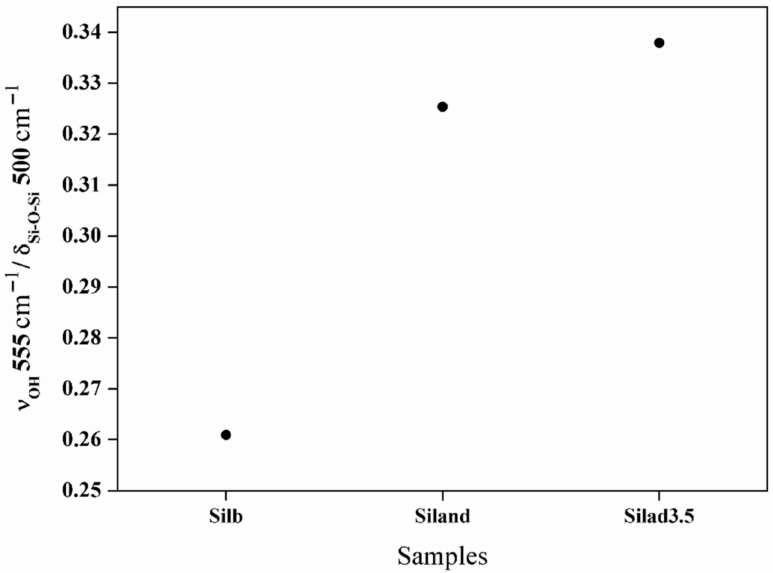
Figure 7. The evolution of the intensity ratio between Si-OH band located around 555 cm − 1 and the structural band located around 500 cm − 1